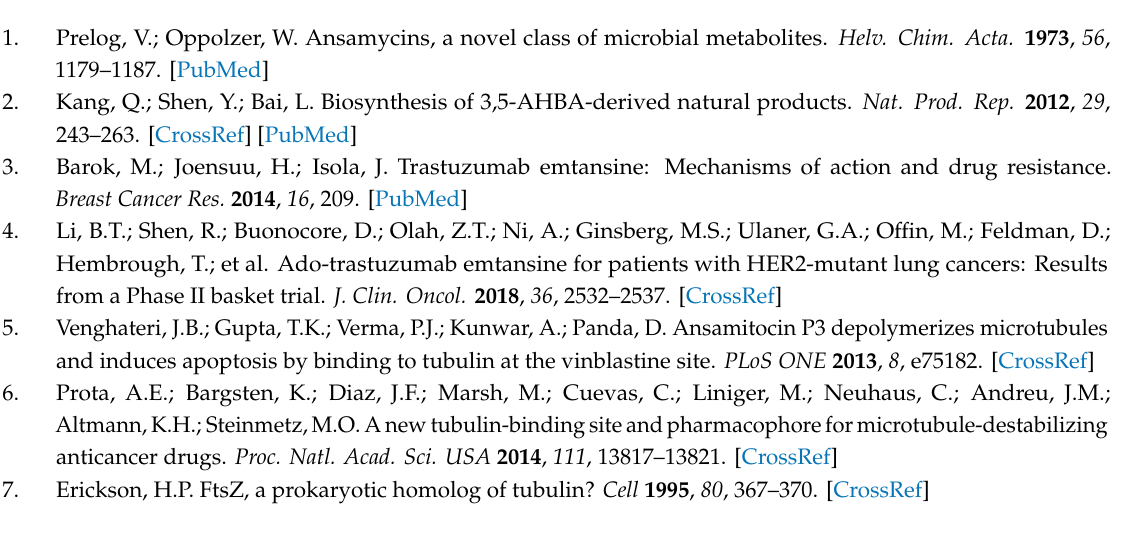
Figure S2: HPLC standard curve of AP-3; Figure S3: Growth of A. pretiosum WXR-24 (a) and WXR-30 (b) on YMG plates containing 300 mg / L or 400 mg / L AP-3. The photos were taken on day 16 after inoculation; Figure S4: Transcription level of ftsZ in WXR-24 and WXR-30; Figure S5: Growth of A. pretiosum WXR-24 and WXR-30 in the fermentation broth; Figure S6: Mycelial morphology of WXR-24 (a and c) and WXR-30 (b and d) on the first day of fermentation, observed by optical microscope under 20x objective (a and b) and 60x objective lenses (c and d); Figure S7: AP-3 yields of WXR-30 in fermentation media supplemented with 16 g / L, 24 g / L or 32 g / L yeast extract; Figure S8: The inhibition of FtsZ assembly by AP-3 with FtsZ from Streptomyces coelicolor (a) and Bacillus subtilis